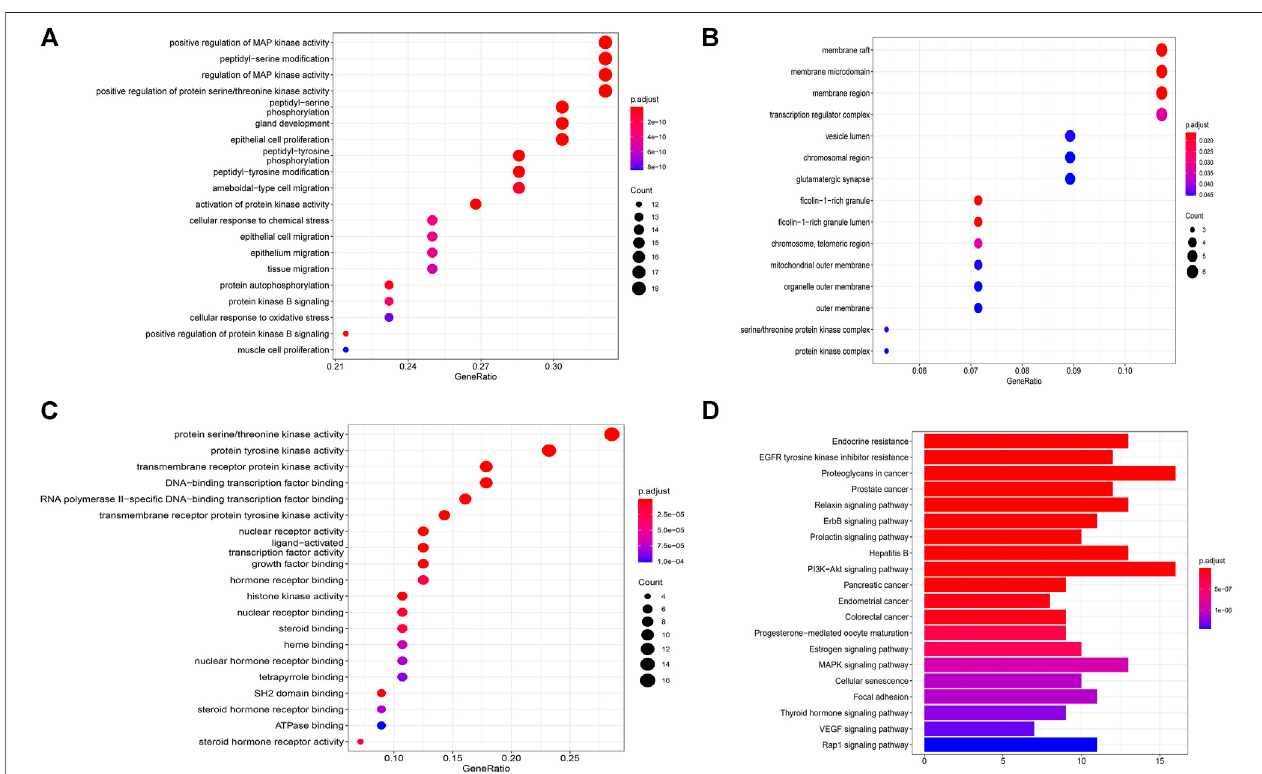
FIGURE4 | Gene Ontology and Kyoto Encyclopedia ofGenesand Genomes pathway enrichmentanalyses. (A – C) The names ofthe biological processes, cellular component and molecular function terms distributed in the ordinate and the degree of enrichment in the abscissa. The size of the dots represents the number of genes; thelargeristhedot,thehigheristhenumberofgenesinthecorrespondingprocess. (D) Thenamesofthepathways distributedintheordinateandthenumber ofgenes enrichedinthepathwaydistributedintheabscissa. p valuesindicatetheimportanceofenrichment;theloweristhe p value,theredderisthecolorofthegraph,and the higher is the enrichment.